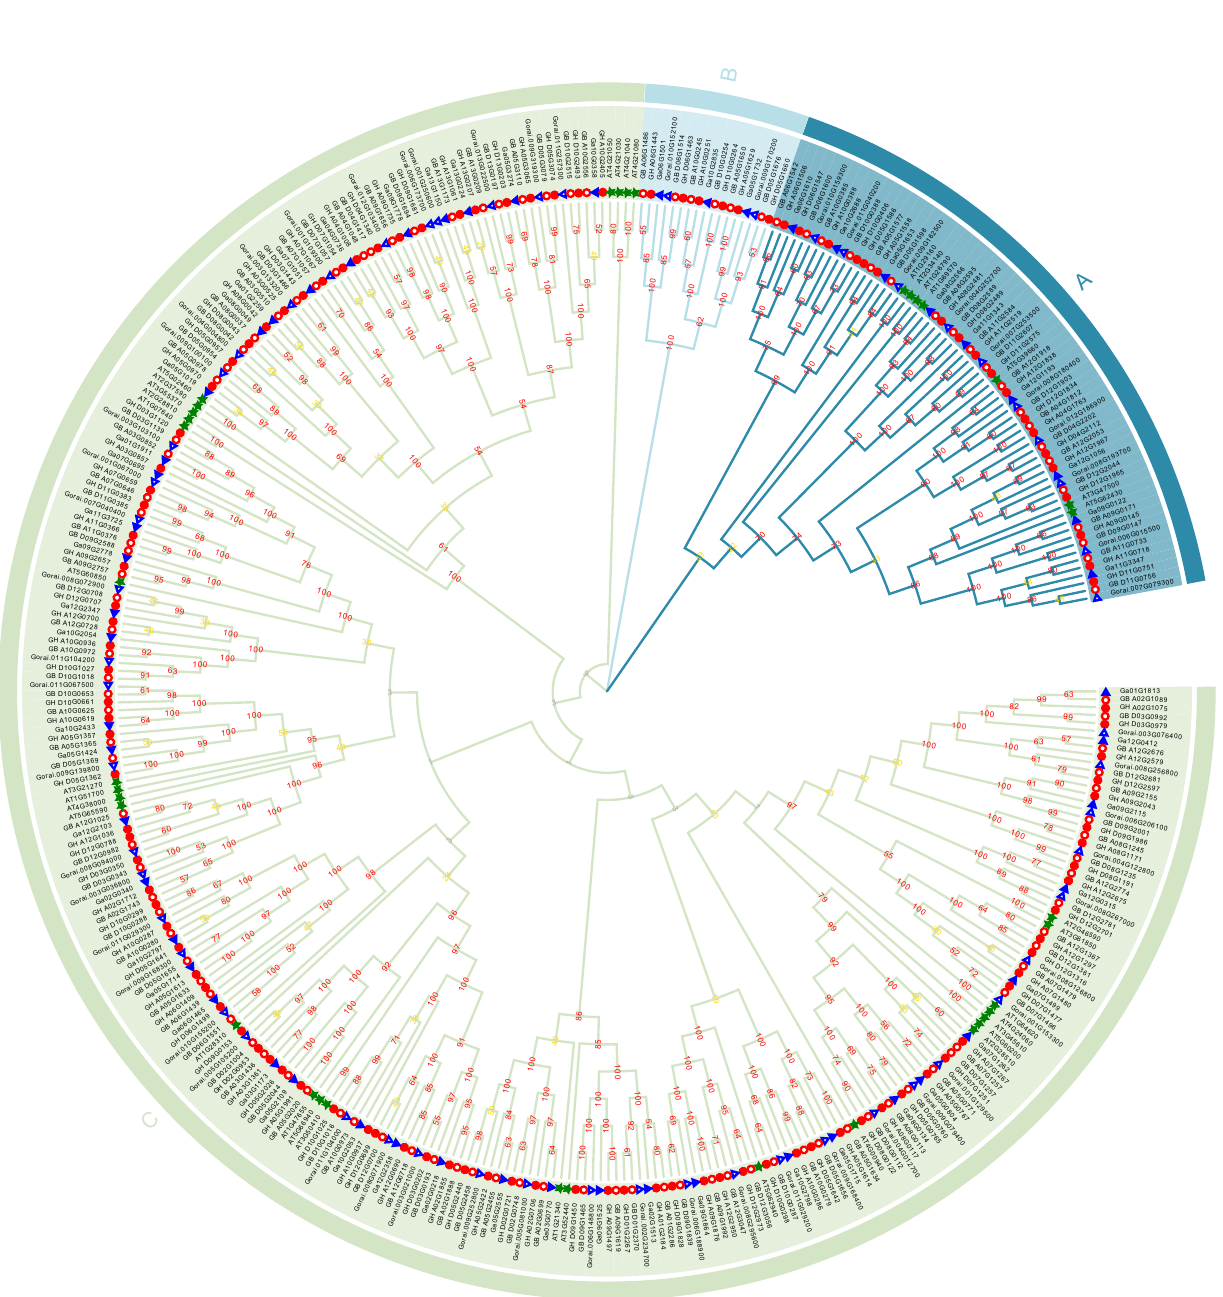
Fig 1. Phylogenetic tree of the Dof gene family. Bootstrapping values are indicated as percentages along the branches. The different background colors indicate different groups. Tetraploid G . hirsutum is indicated by red solid circle and tetraploid G . barbadense is indicated by red hollow circle; diploid G . arboreum is indicated by blue solid triangle and G . raimondii is indicated by blue hollow triangle; the Arabidopsis thaliana is indicated by green star.